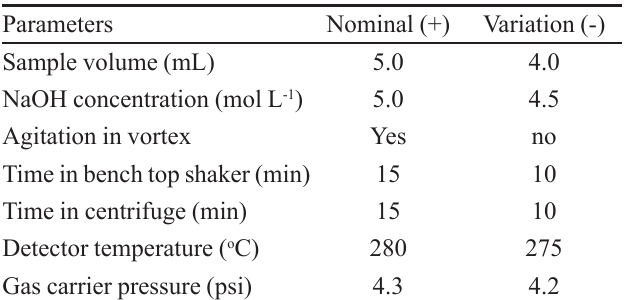
TABLE I - Robustness parameters Parameters